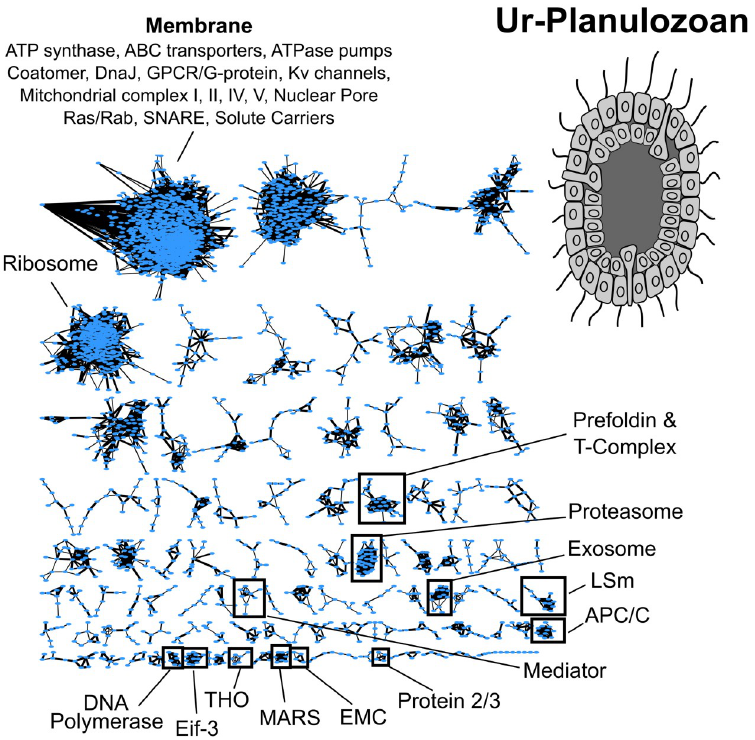
Fig 5. Reconstructed orthogroup interaction network for the most recent common ancestor of planulozoans (cnidarians + bilaterians). The model successfully reconstructs known soluble complexes and groups membrane proteins into a large clump. Edge widths are proportional to the z-score transformed score from the